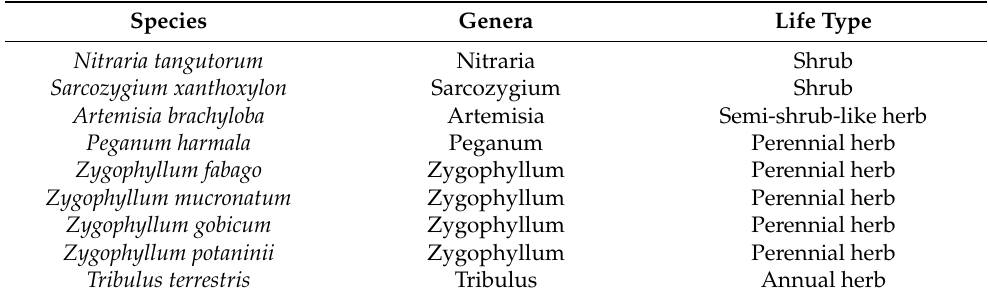
Table 2. Species composition of Zygophyllaceae plants in arid and semi-arid regions of China. Species